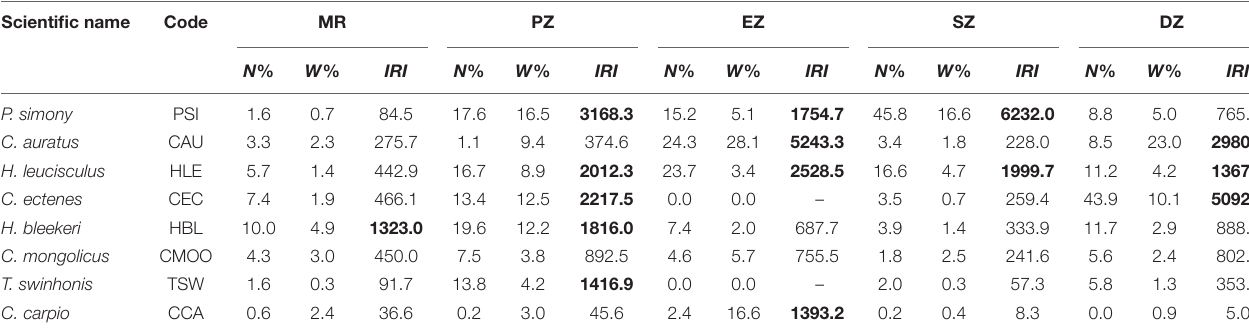
FIGURE 2 | The total number of fish species sampled (i.e., species richness) parsed into different feeding types (omnivores, piscivores, planktivores, and herbivores) and propensity for movement (migratory or resident) among the Mangshe River (MR) and different purification zones of Lake Yanlong (PZ, the pretreatment zone; EZ, the emergent macrophyte zone; SZ, the submerged macrophyte zone; DZ, the deep purification zone). TABLE 3 | The percent relative abundance ( N %) and biomass ( W %) and the index of relative importance ( IRI ) of dominant fish species sampling from the Mangshe River (MR) and from different purification zones of Lake Yanlong (PZ, the pretreatment zone; EZ, the emergent macrophyte zone; SZ, the submerged macrophyte zone; DZ, the deep purification